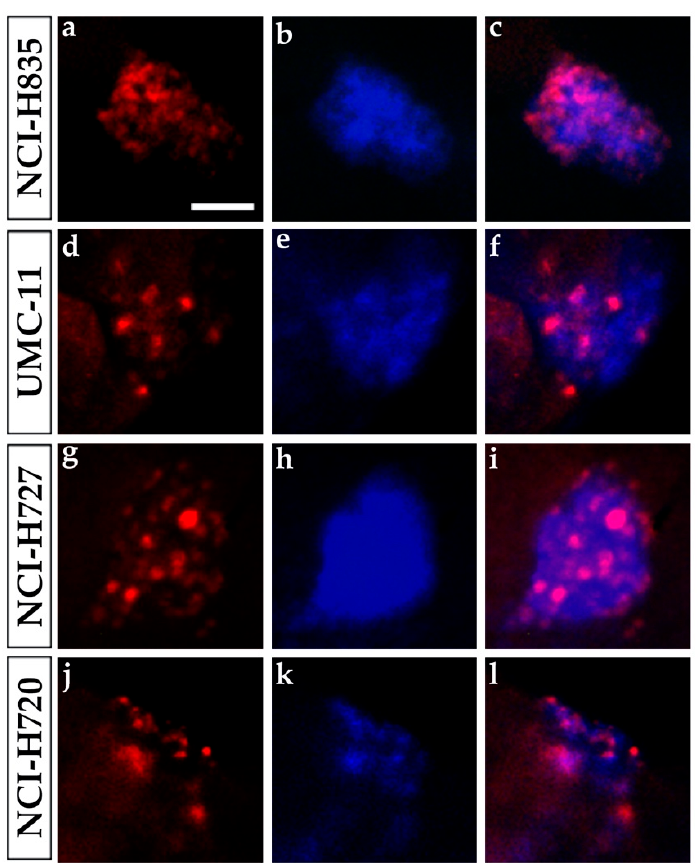
Figure 5. Ki-67 immunostaining of lung carcinoid grafted embryos. Representative images of 48 hpi Tg(fli1a:EGFP) y1 zebrafish embryos at the level of the graft regions after immunofluorescence assay to detect Ki-67 localization (red). Embryos were implanted with NCI-H835 ( a–c ), UMC-11 ( d–f ), NCI-H727 ( g–i ), and NCI-H720 ( j–l ) cells. Injected lung carcinoid cells were previously blue-stained ( b , e , h , k ). The merge of red and blue channels ( c , f , i , l ) showed that Ki-67 staining is tumor cell specific. Scale bar: 50 µm.